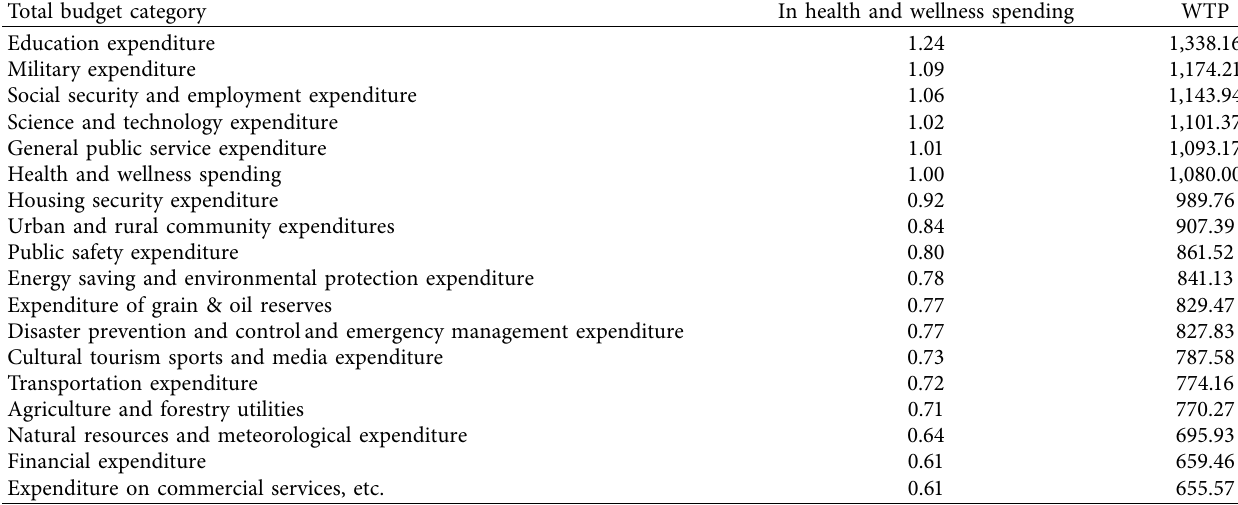
Table 6: WTP in total budget expenditure categories.